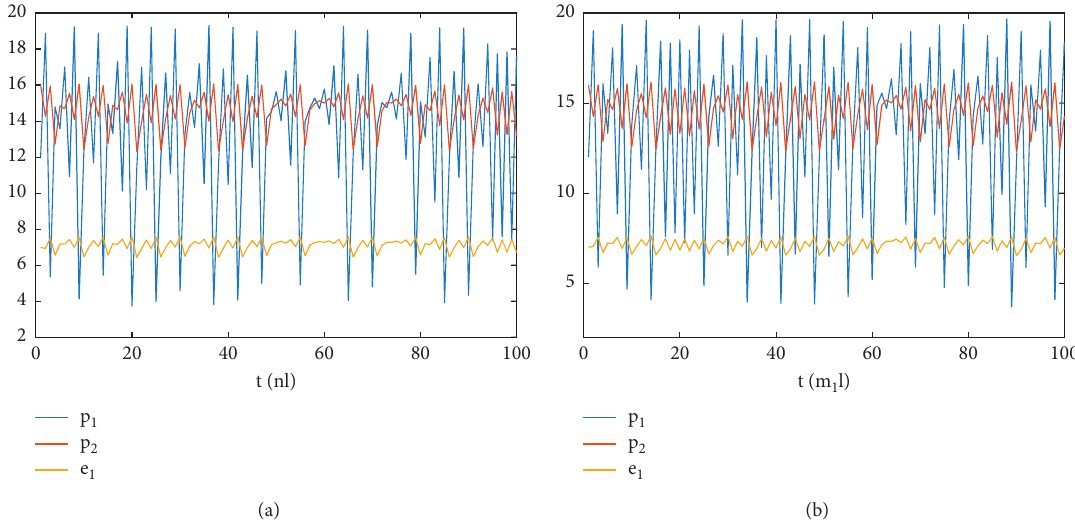
Figure 12: The time series of p